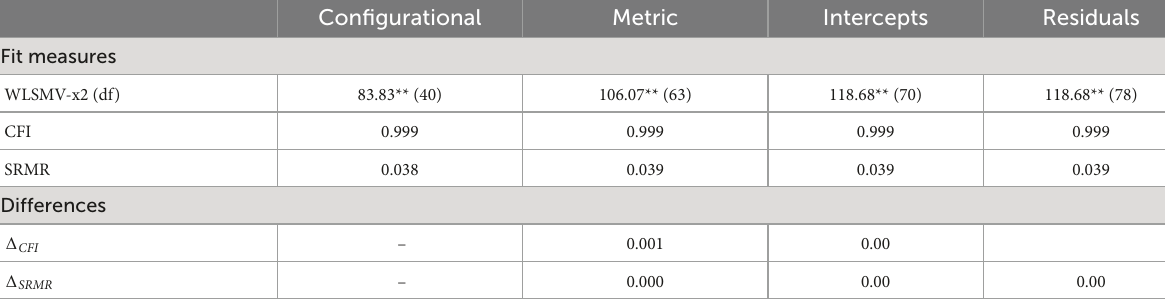
TABLE 7 MOS-S measurement invariance (group = sex).